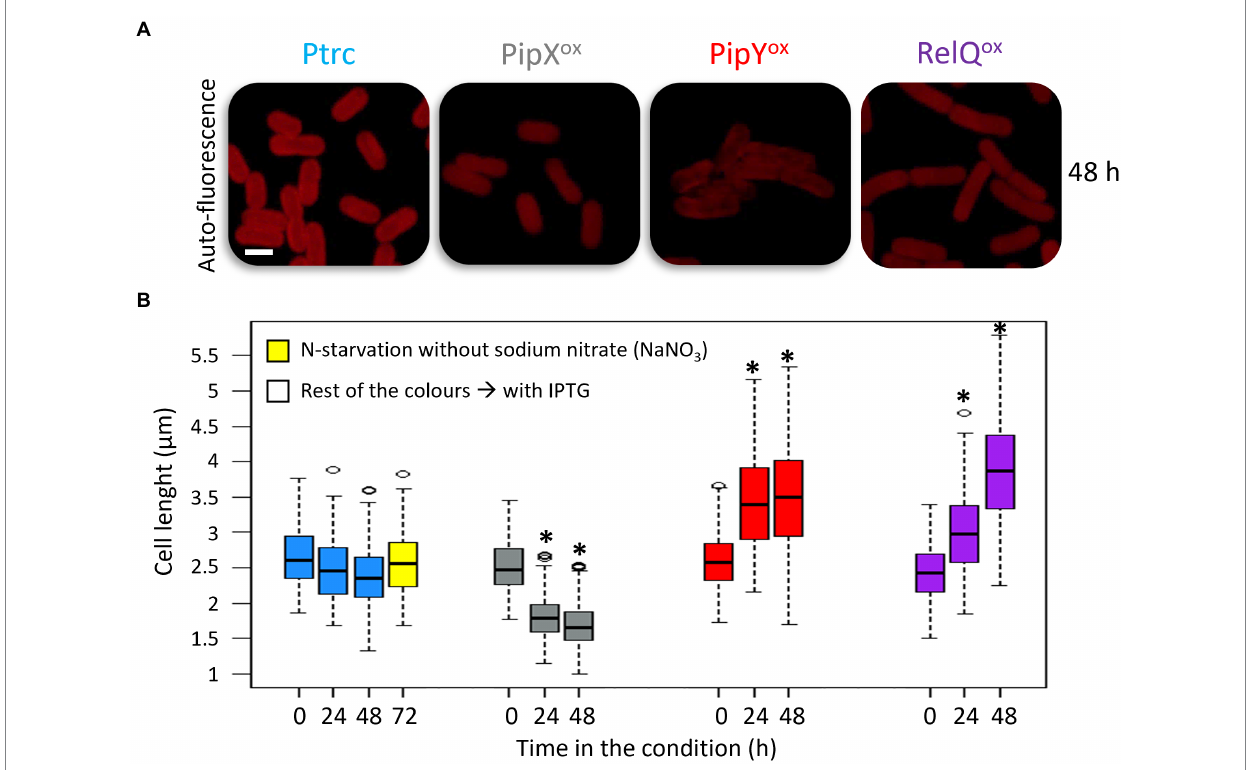
FIGURE 4 PipX ox has opposite effects on cell length than PipY or RelQ. (A) Confocal micrographs showing the auto-fluorescence signal (Ex 633 nm) after 48 h and (B) cell-length boxplots of cells grown in BG11 with IPTG for the indicated number of hours. Scale bar, 2 μ m. The median, the box from the first to the third quartile, and the outliers (dots) are represented. The number of cells measured from two biological replicates was n = 200. Wilcoxon rank sum test analysis of cell length data between Ptrc and overexpression strains in each timepoint produced p -values <2.2e-16 ( * ). Labels and boxplots are colored to indicate the strains as follows: Ptrc-light blue, PipX ox -gray, PipY ox -red, RelQ ox -purple, Ptrc without nitrogen-yellow. Other details as in Figure